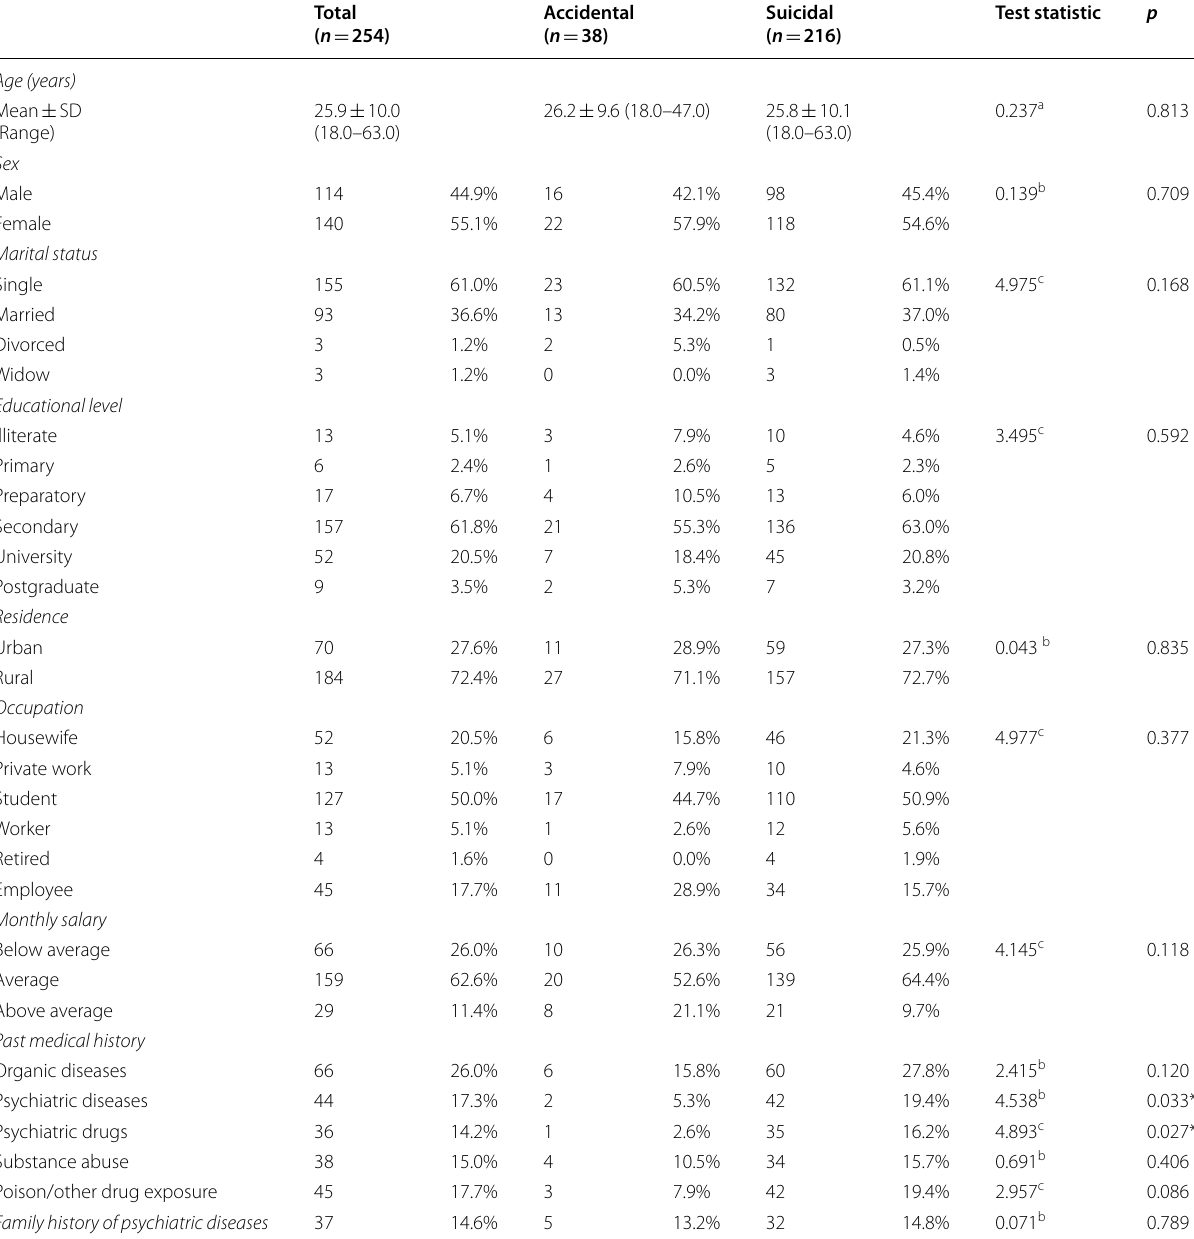
Table 1 Basic patients’ demographics ( n